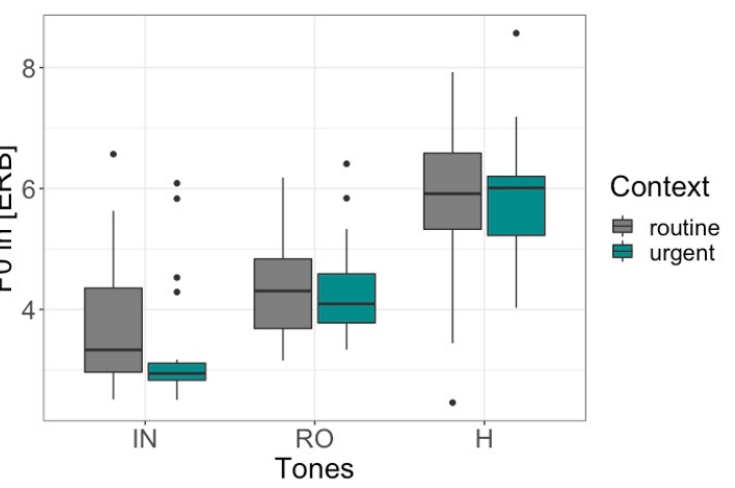
Figure 9. F0 scaling of the rising contour in the routine and urgent context in CF.